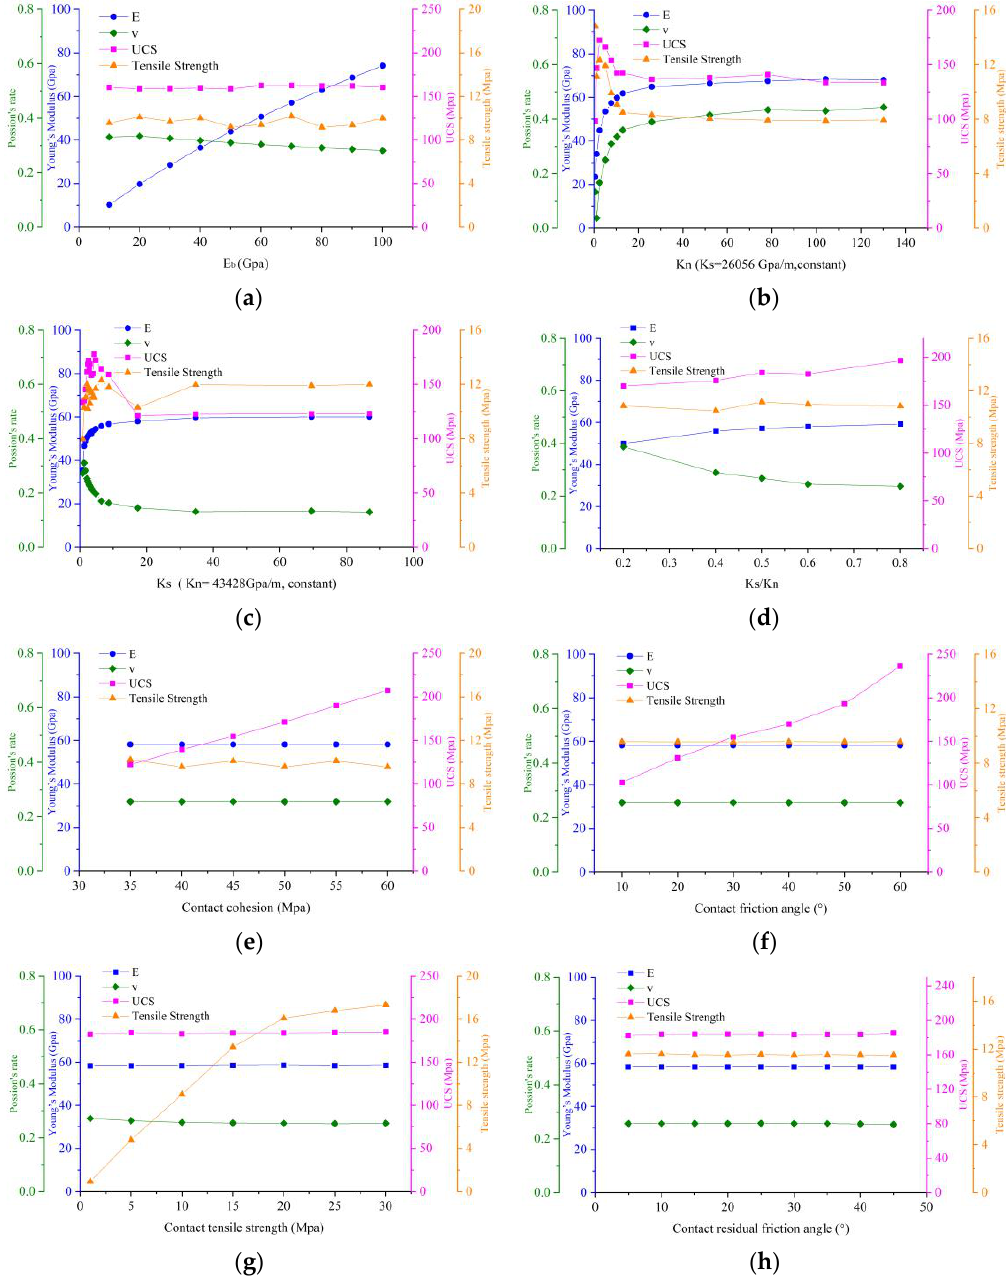
Figure 2. The mechanical properties of the macroscopic sample according to each influencing micro-connection parameters: ( a ) Young’s modulus of the block ( E b ) , ( b ) normal stiffness ( k n ) , ( c ) shear stiffness ( k s ) , ( d ) stiffness ratio (ks/kn), ( e ) contact cohesion ( c j ) , ( f ) contact friction angle ( ϕ j ) , ( g ) contact tensile strength ( σ tj ) , ( h ) contact the residual friction angle ( ϕ jr ).